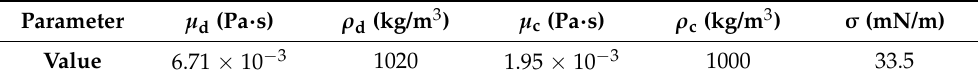
Table 1. Physical properties of the continuous phase and the disperse phase.